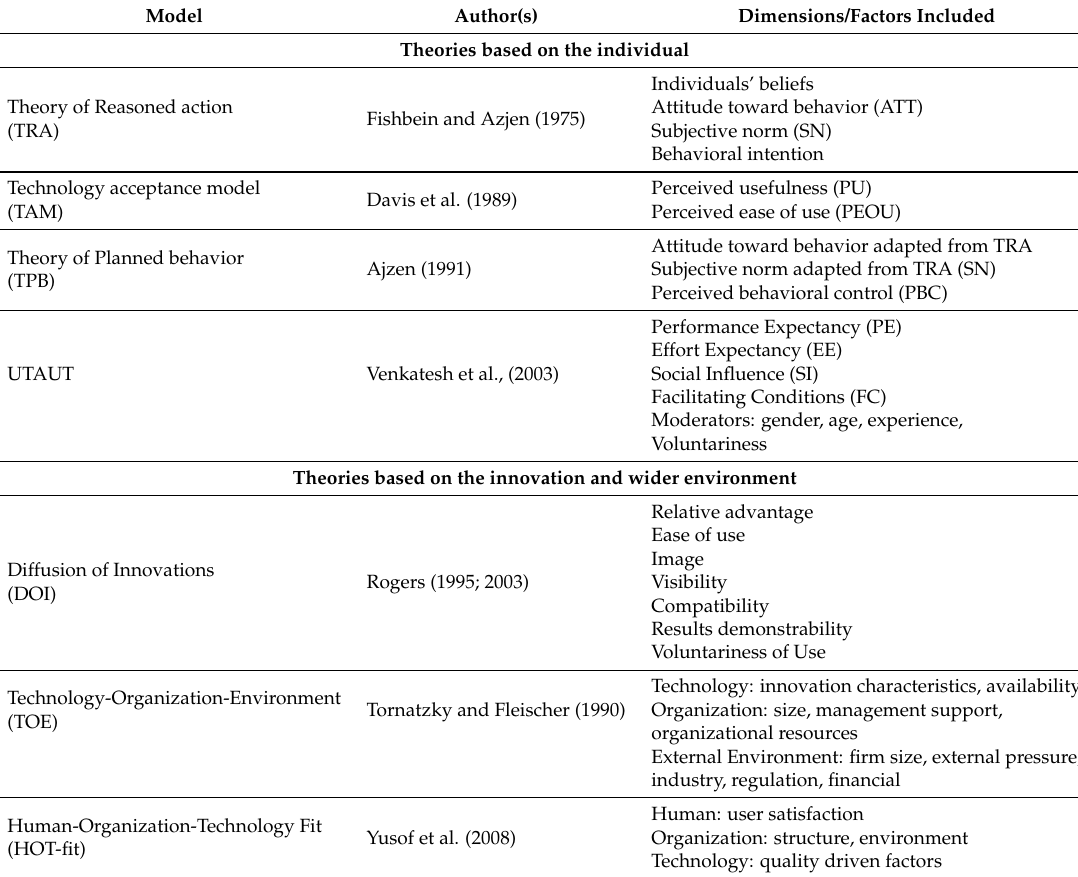
Table 1. Technology adoption